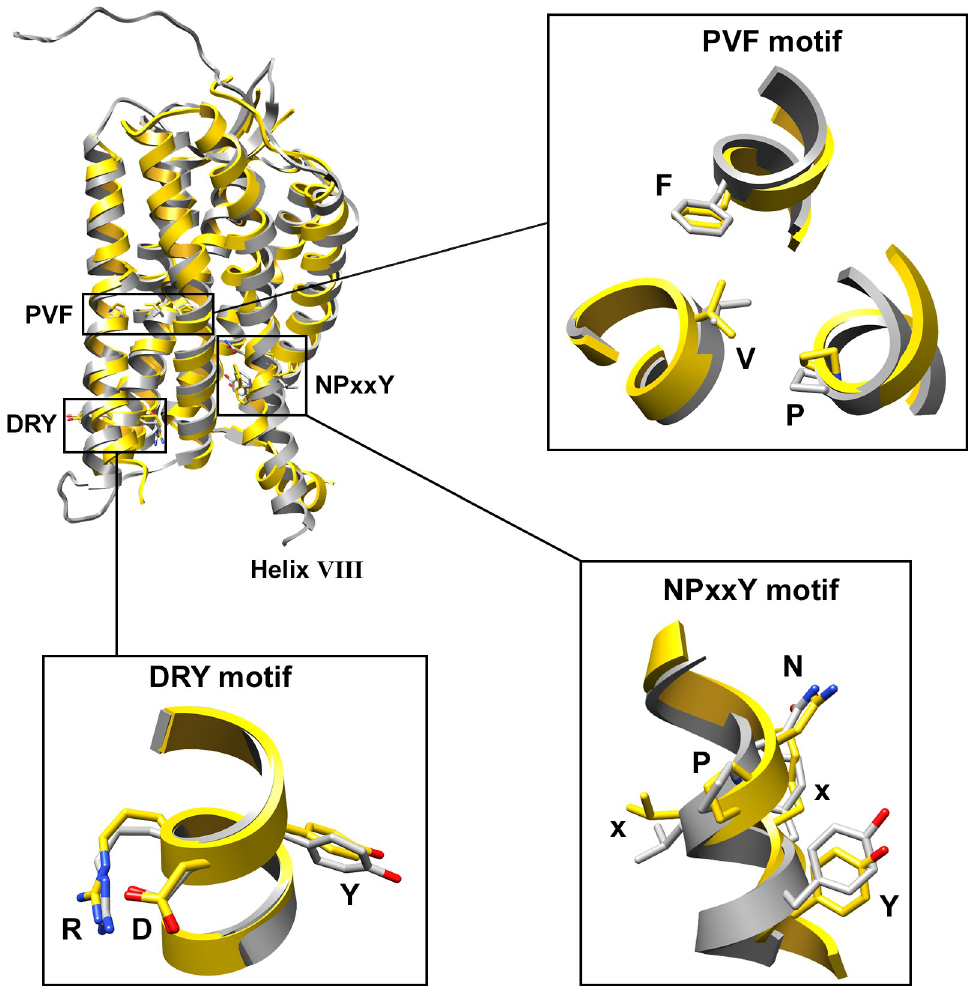
Fig 2. Comparison of the apo-AT 1 R model to the inactive AT 1 R crystal structure (4YAY). The apo-AT 1 R model (grey) is aligned to the inactive AT 1 R (gold), and the activation motifs are expanded in boxes with the residues labeled by single amino acid letter and structure shown as sticks colored by atom type, with the carbons grey and gold for the apo-AT 1 R model and 4YAY crystal structure,